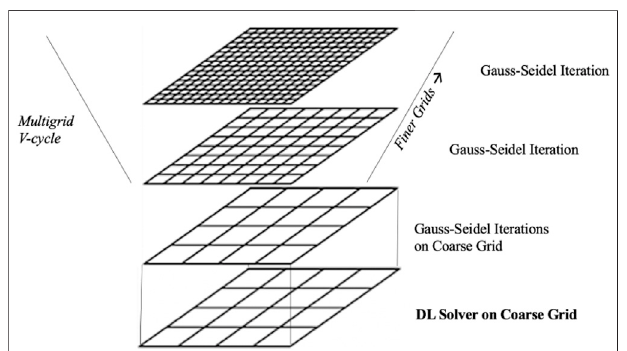
FIGURE7 | The hybridsolvers relies on theDL linearsolver to determine the solution on a coarse grid that is re fi ned through a multigrid V-cycle performing Gauss-Seidel iterations on fi ner